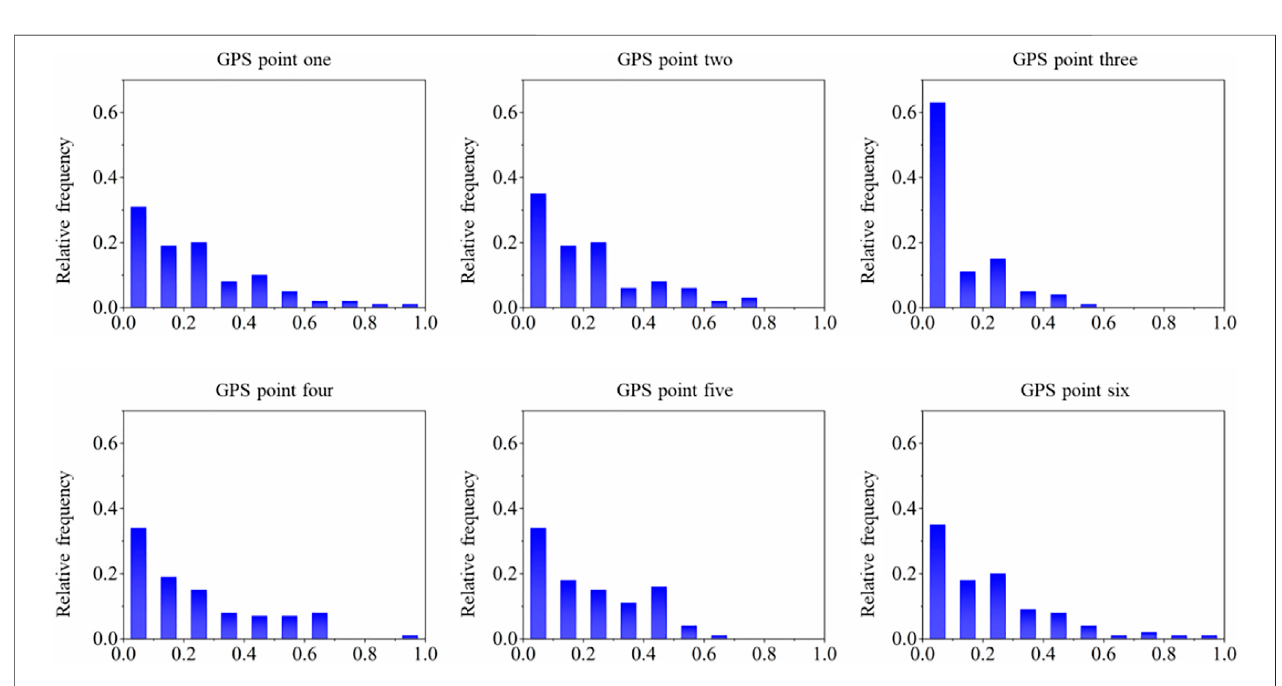
FIGURE 3 | Histograms of the scaled test dataset for all GPS points.